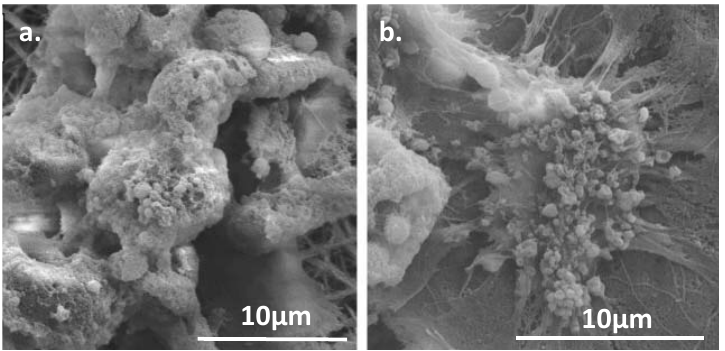
Figure 13. ( a ) Mineral depositions on the electrospun nanofibrous scaffolds: apatite-like morphology of deposit at higher magnification, ( b ) Globular minerals and collagen bundles associated with a single cell viewed at higher magnification. Reproduced from [58] with permission from Elsevier.